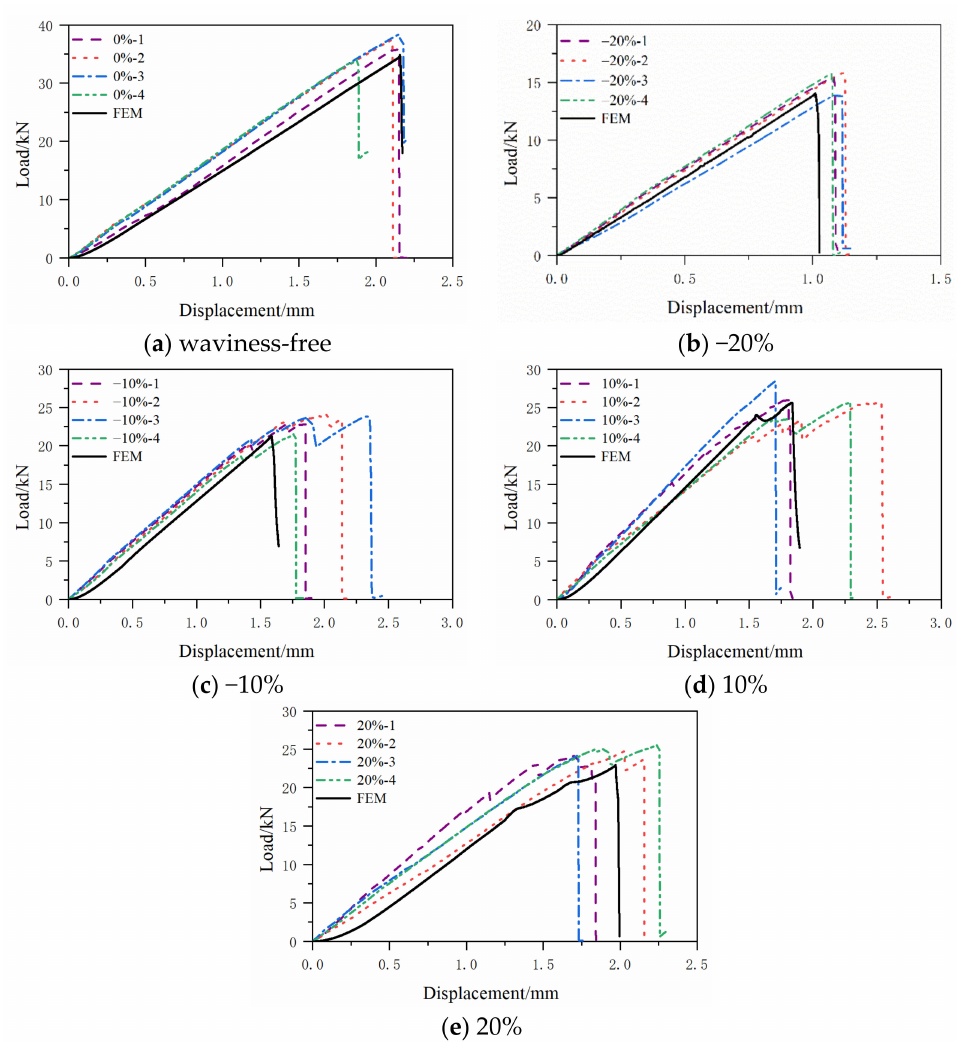
Figure 13. Comparison of compressive load-displacement curves of experiments and